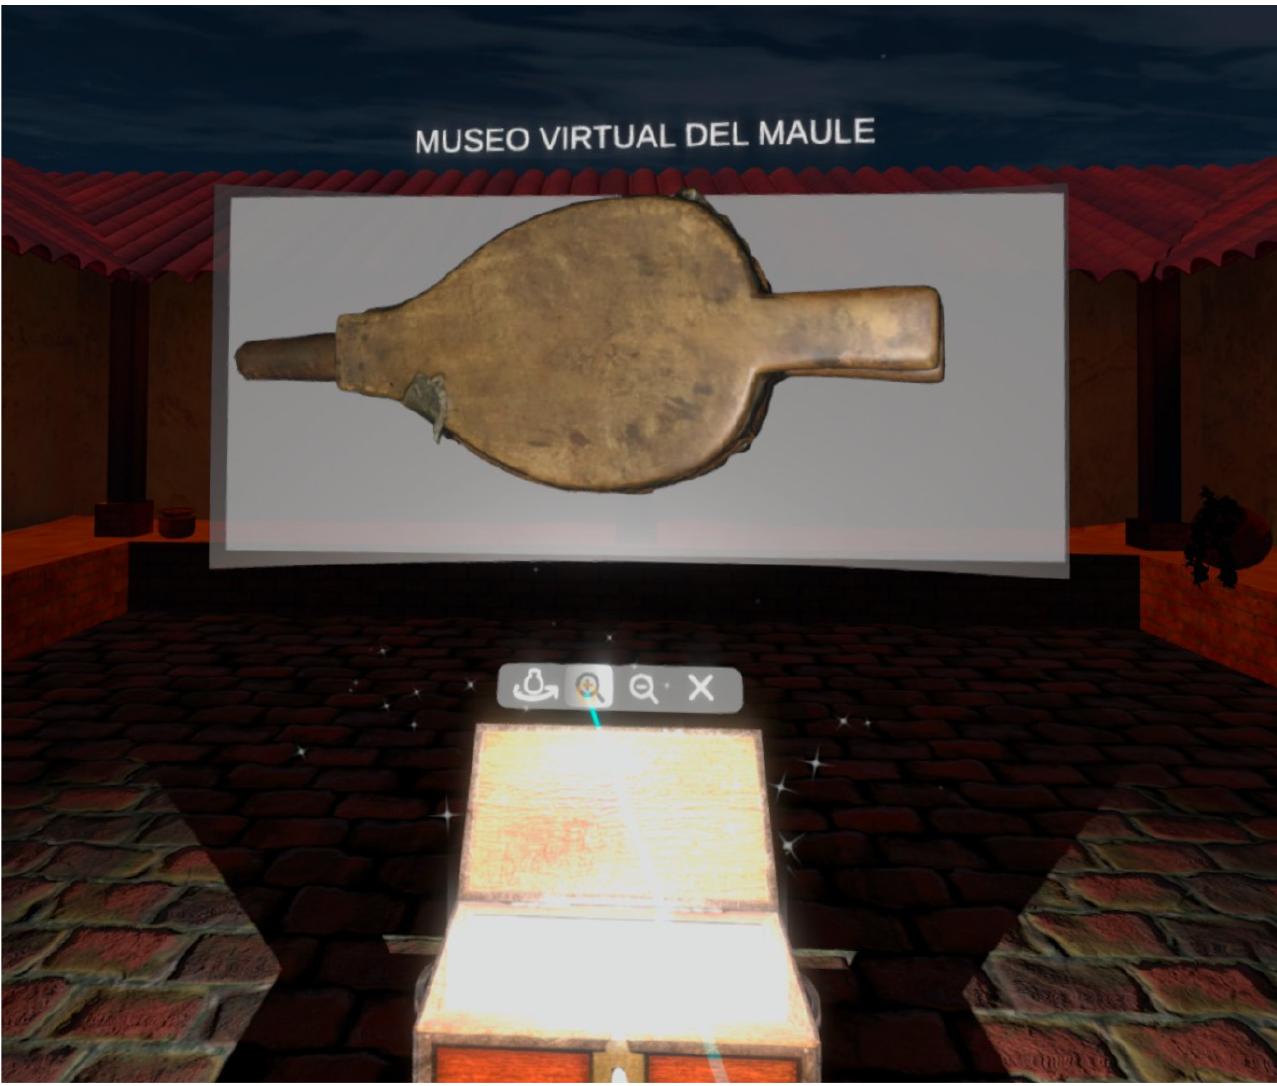
Figure 5. Visualization panel: Zooming in on the bellows (piece from Museo Histórico de Villa Alegre); in the interface, the user can select auto spin or zoom in or out and go back to the original presentation (this picture was taken with the screenshot functionality of Oculus Quest).